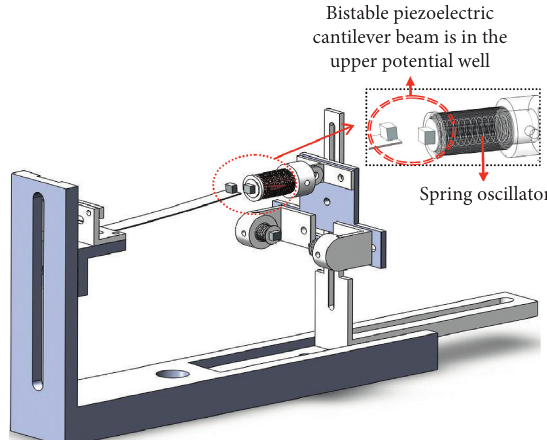
Figure 5: Schematic diagram of the experimental model.